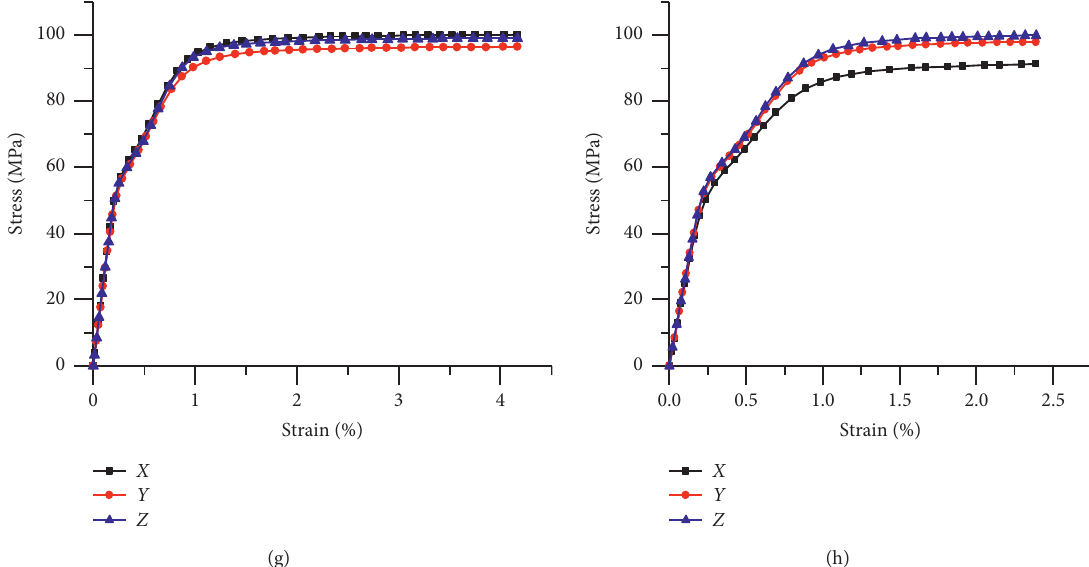
300-1 , S5 300-2 , S5 400-1 , and